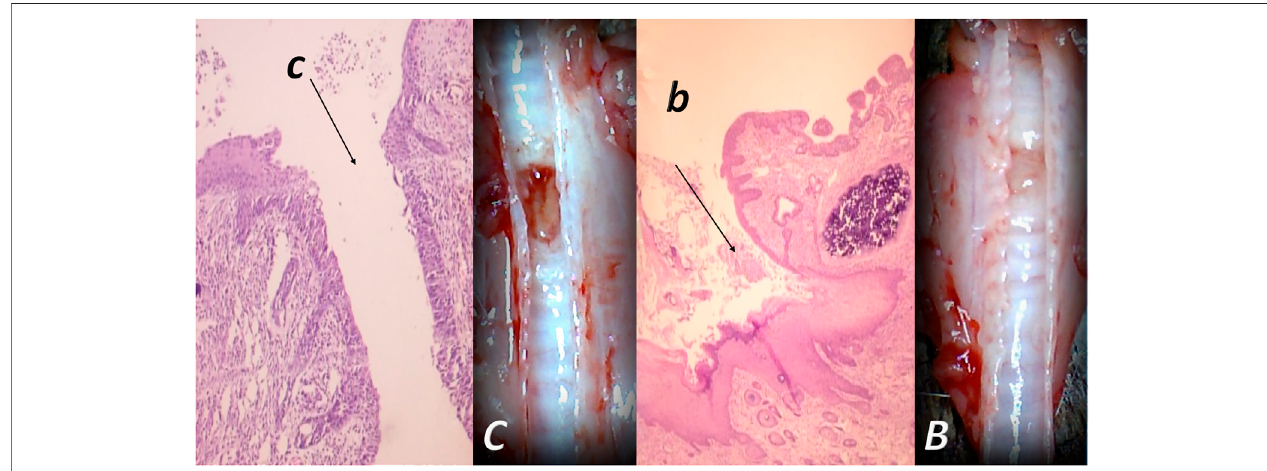
FIGURE 3 | Tracheocutaneous fi stulas and BPC 157 therapy. After injury induction, BPC 157 dissolved in saline (10 μ g, 10 ng/kg body weight) given per-orally in drinking water till the sacri fi ce (0.16 μ g/ml, 0.16 ng/ml, and 12 ml/day/rat). At postsurgery day 7, fi stula closure, closed tracheal defect, and closed skin defect ( B, b ) (arrow) wereobservedinBPC157rats.Contrarily, incontrols, fi stularemained open, fi stulouschannelwasformed intheskin,and opentracheal defectswereobserved ( C, c ) (arrow) (HE, x4).